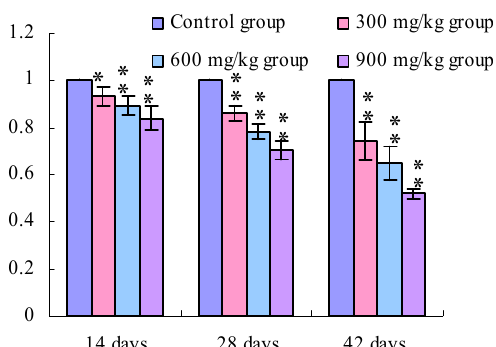
Figure 3. The TLR2-2 mRNA expression levels in the ileac mucosa in